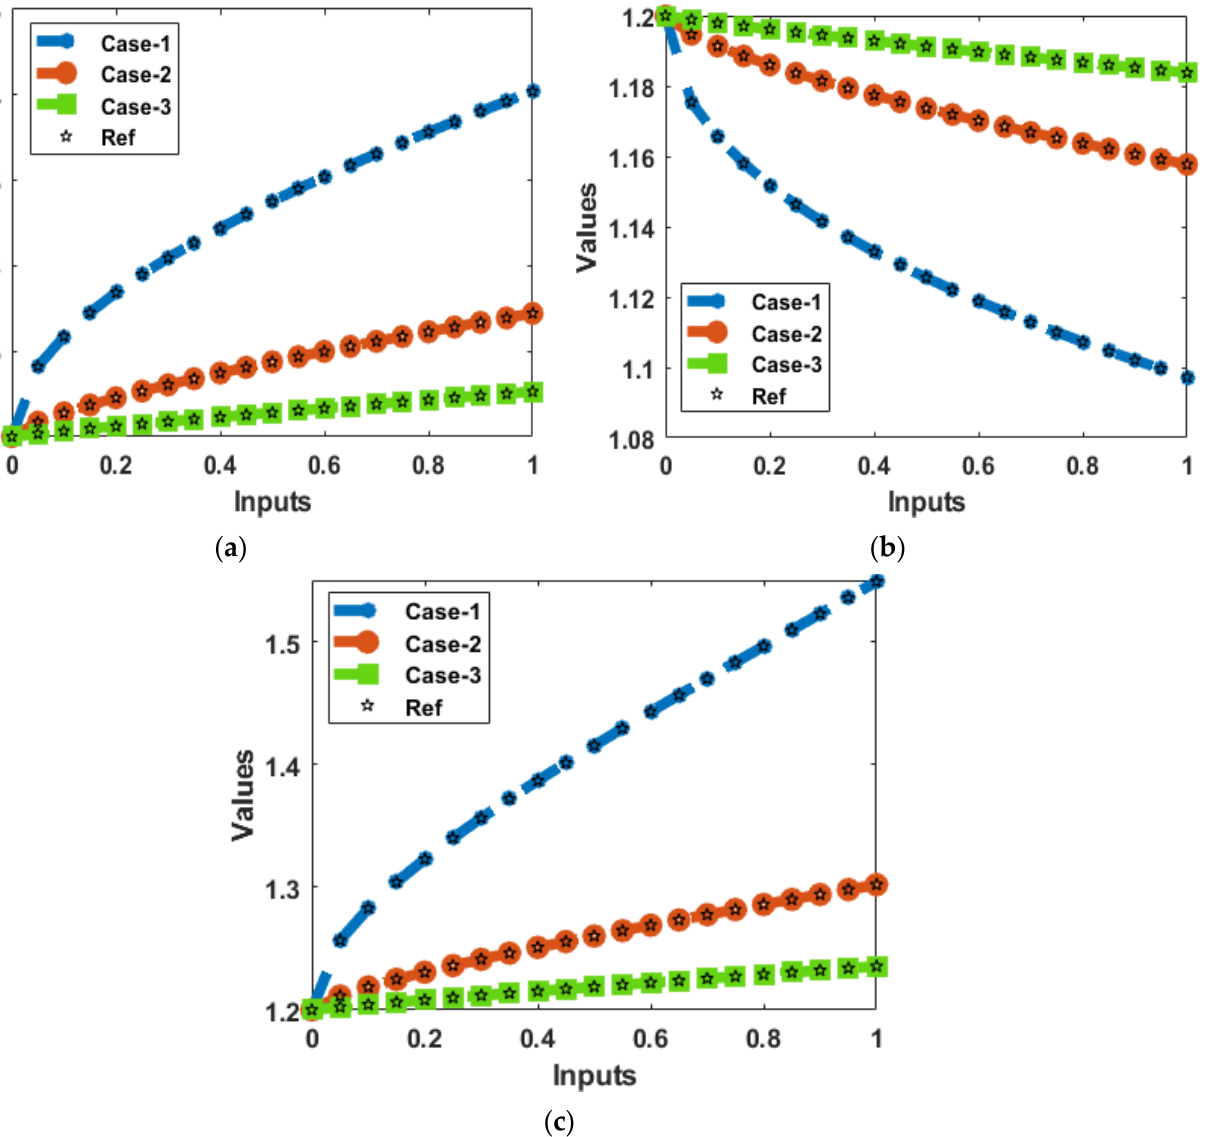
Figure 6. Results overlapping for the mathematical form of the FKFS model. ( a ) Results of the logistic prey L ( x ); ( b ) Results of the Holling type M ( x ); ( c ) Results for the top-predator N ( x ).